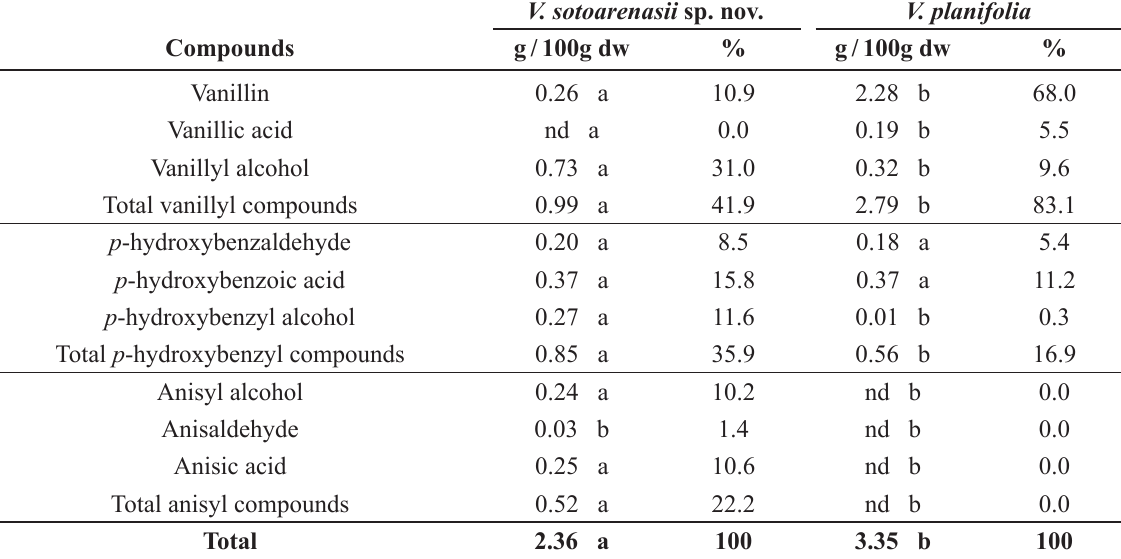
Table 5. Means of volatile compounds quantified by HPLC in mature beans of V. sotoarenasii M.Pignal, Azofeifa-Bolaños & Grisoni sp. nov. (CR0068; 3 samples) and V. planifolia Jacks. ex Andrews (CR0196, CR0038, CR0040; 9 samples). Contents are expressed as grams of compound per 100 g dry matter. nd = compound not detected. Averages with different letters within rows are significantly different (p <